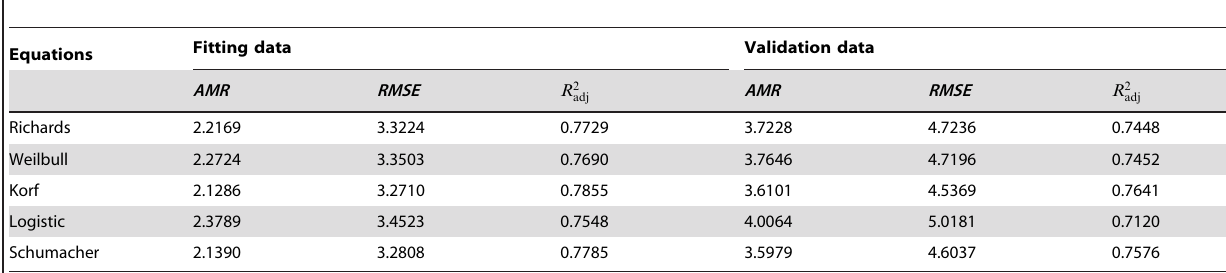
Table 3. Performance criteria for individual-tree diameter growth equations.